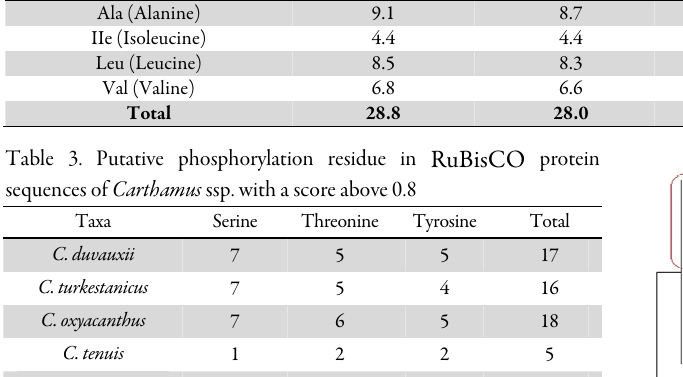
Fig. 2. RuBisCO proteins in Carthamus ssp. determined by a score above a threshold of 0.5 Table 2. The RuBisCO proteins with aliphatic index (Al) values and their corresponding number of aliphatic residues Aminoacids